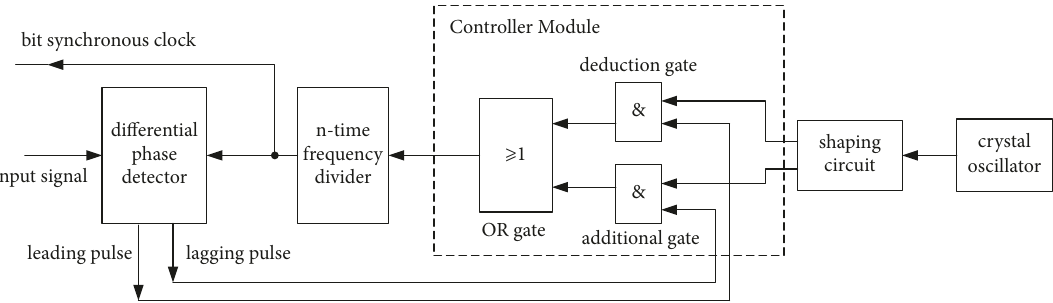
Figure 1: Structure diagram of DPLL.